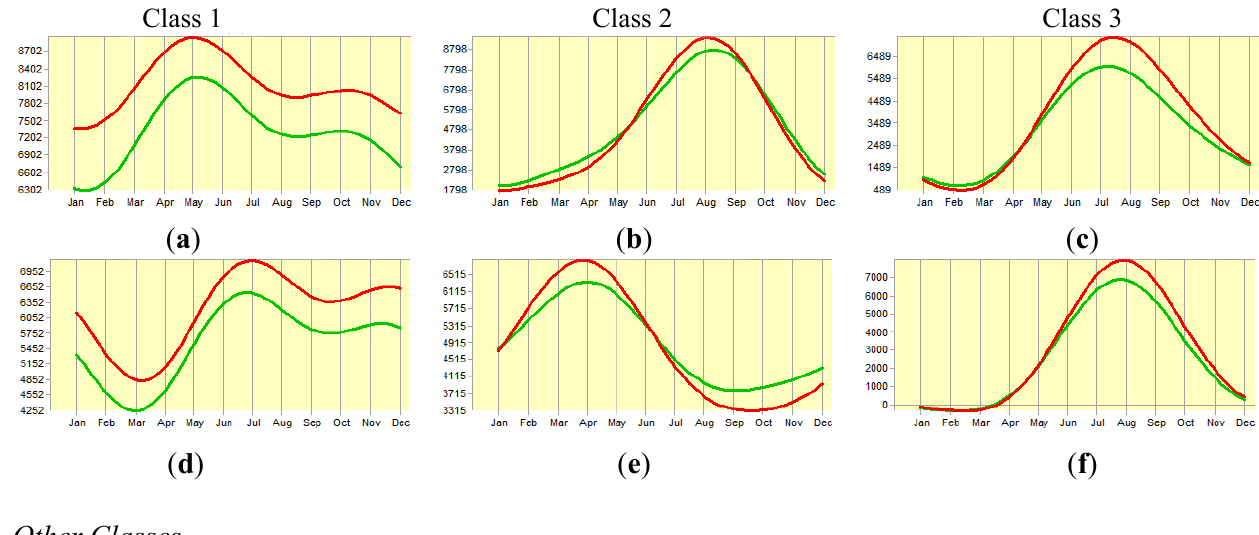
Figure 4. Examples of seasonal trends representative of each of the three major trend classes from the 1982–2011 series. In each graph the X axis portrays the month of year while the Y axis represents NDVI x10,000. The green curve represents the characteristic seasonal curve at the beginning of the series while the red curve represents the characteristic seasonal curve at the end of the series. The difference between the two represents the change resulting from the trend. ( Left ) represent examples belonging to Class 1. ( Middle ), are examples from Class 2. ( Right ) are examples from Class 3. ( a ) is from northwest Spain at 7.9°W and 42.8°N. ( b ) represents central Colombia at 71.6°W and 5.0°N. ( c ) was sampled at 94.4°W 42.0°N in Nebraska, in the United States. ( d ) is from northern Madagascar at 45.5°E and 17.5°S. ( e ) was measured at 104.5°W and 49.5°N in southern Saskatchewan. ( f ) represents northern Alaska at 161.2°W and